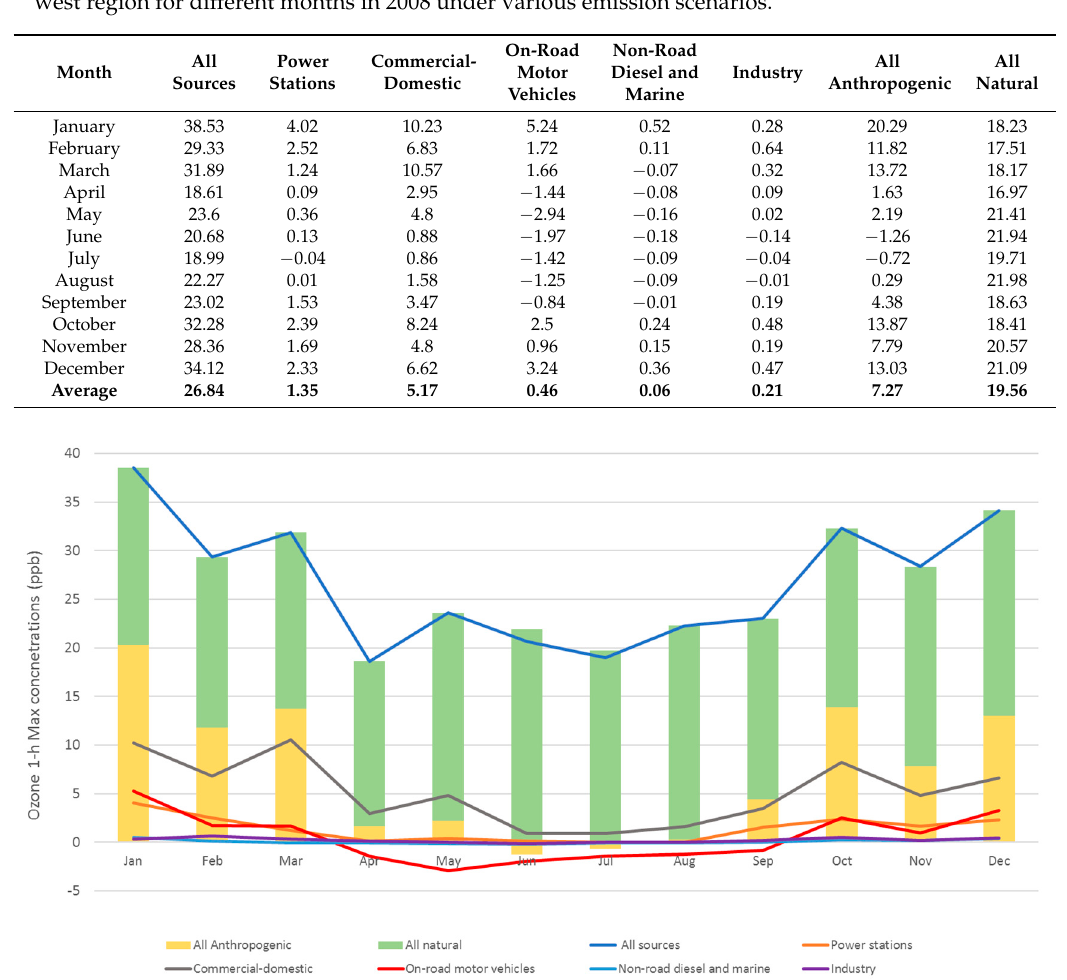
Figure A1. Contribution of all anthropogenic and natural emissions (bar graph) and different anthropogenic sources (line graph) to the monthly average of daily maximum 1-h ozone concentration in 2008 in the Sydney west region.